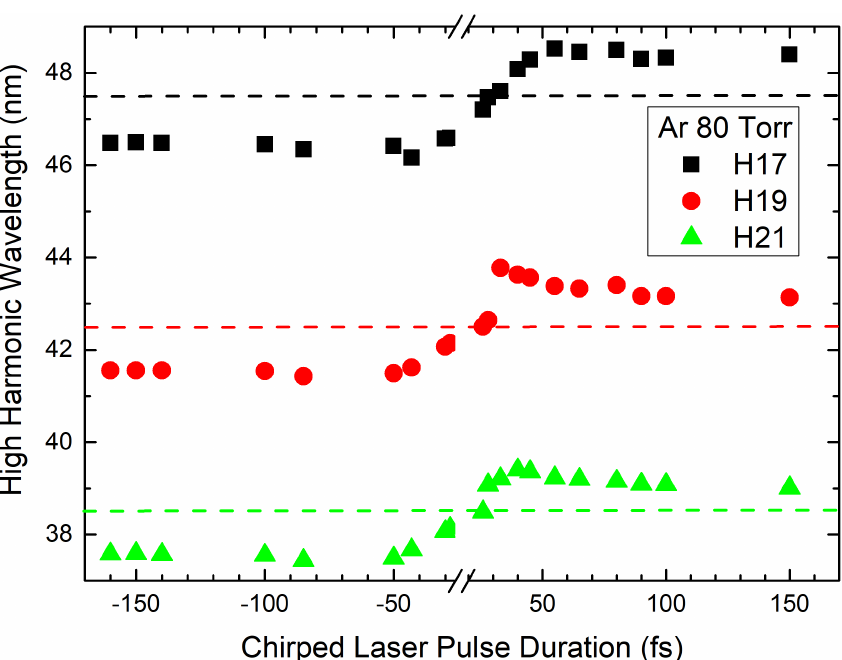
Figure 6. Experimentally determined spectral shift of the 17th (black solid square), 19th (red solid cirlce), and 21st (green solid triangle) high-order harmonics as a function of the chirped laser pulse duration for the pressure of 80 Torr of Figure 3. Dashed horizontal lines correspond to the unshifted harmonic peak positions. Estimated error bars are within the data